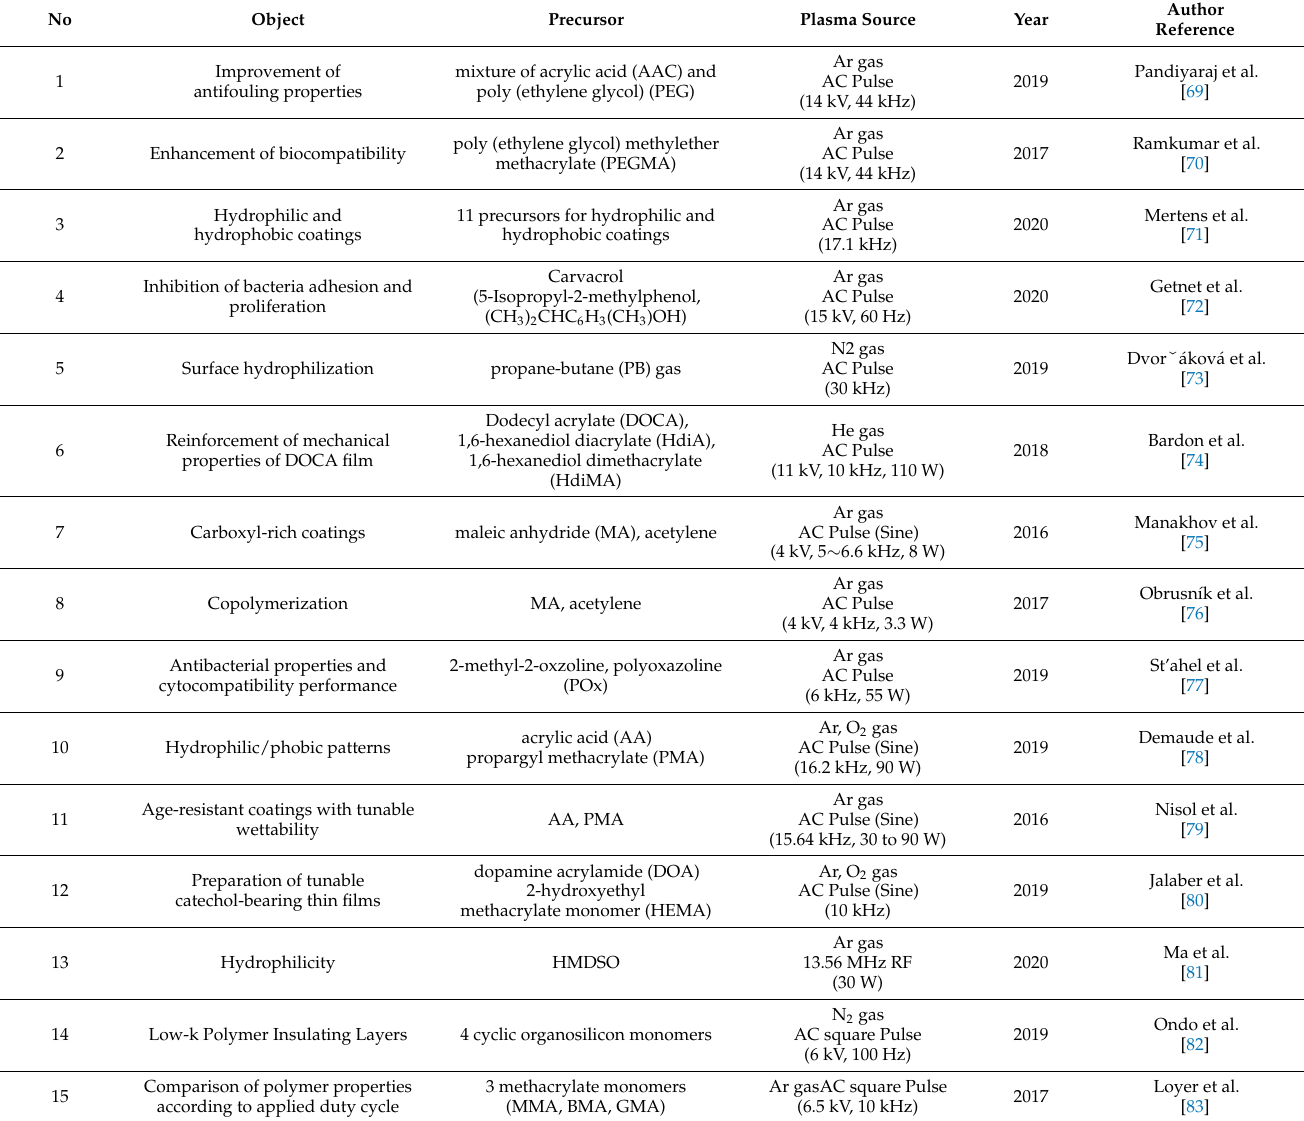
Table 2. Summary of the synthesis of polymer films using planar DBD